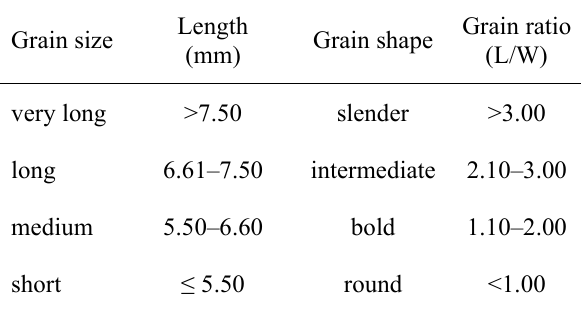
Table 2. Morphological classification of rice grain into four categories based on its relative length (L) and width (W). Source: Khan et al .